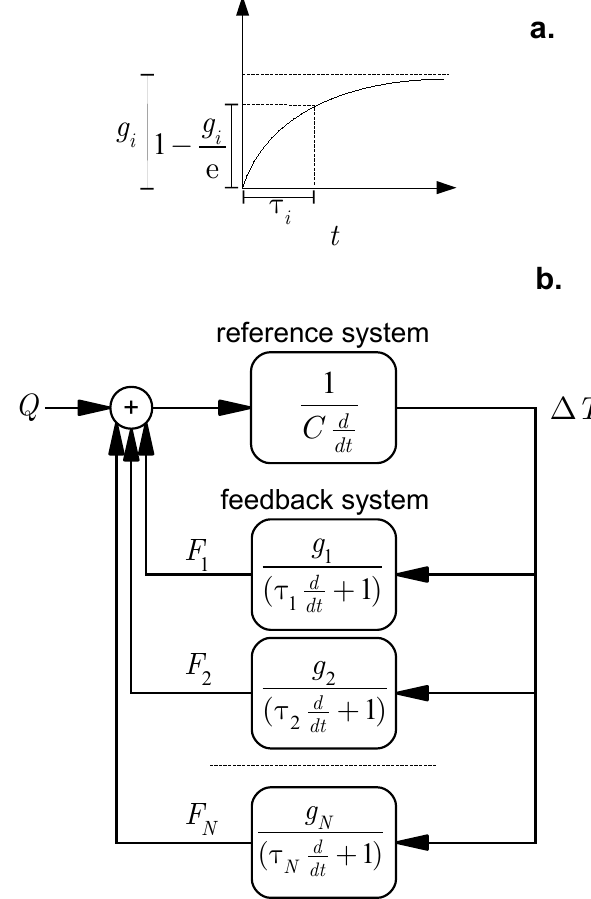
Fig. 1. (a) The generic response of the first order feedback elements shown in (b) , showing the time constant τ in relation to its feedback amplitude g